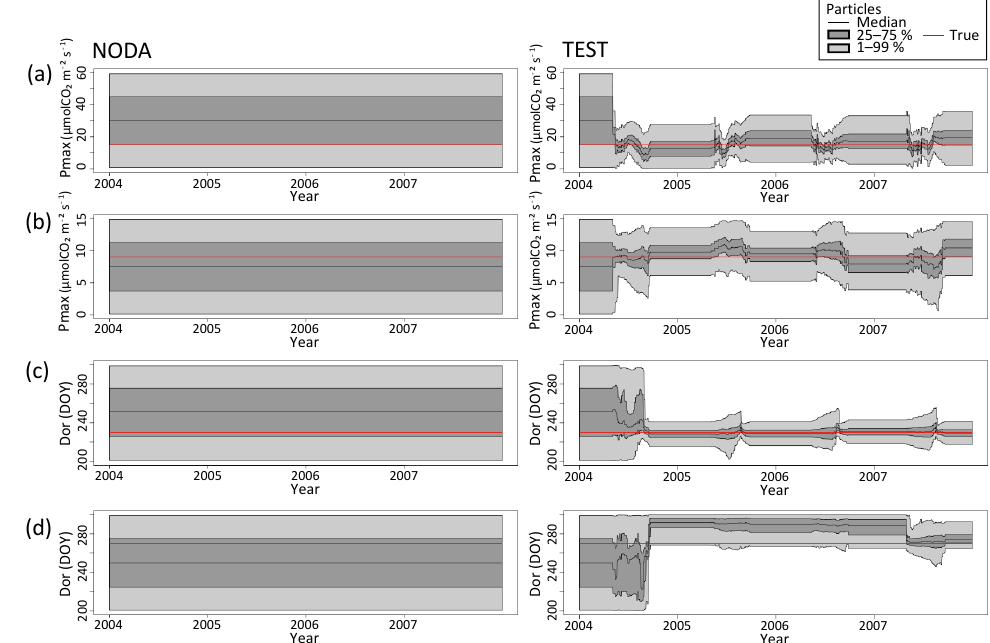
Figure 4. Similar to Fig. 3 but for the model parameters: (a) Pmax for tree, (b) Pmax for grass, (c) Dor for tree, and (d) Dor for grass. There is no observation for these